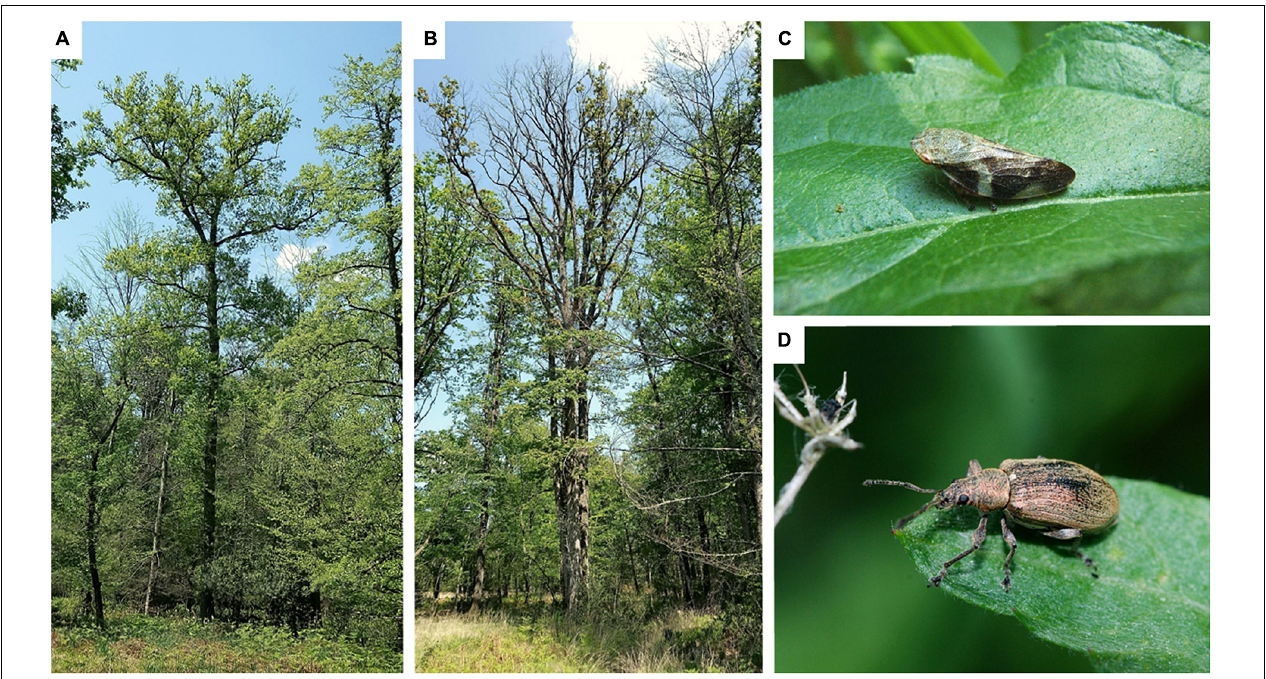
FIGURE 1 | Oaks ( Quercus petraea ) exhibiting moderate (A) and pronounced (B) symptoms of decline with a reduced foliage density and an accumulation of dead branches. Oak decline will have contrasted effects on canopy-dwelling insects: negative for the sap-feeding Aphrophora alni (C) , but positive for generalist leaf-feeder Phyllobius pyri (D) . Photo credits: Aurélien Sallé (A,B) and Sébastien Damoiseau (C,D)